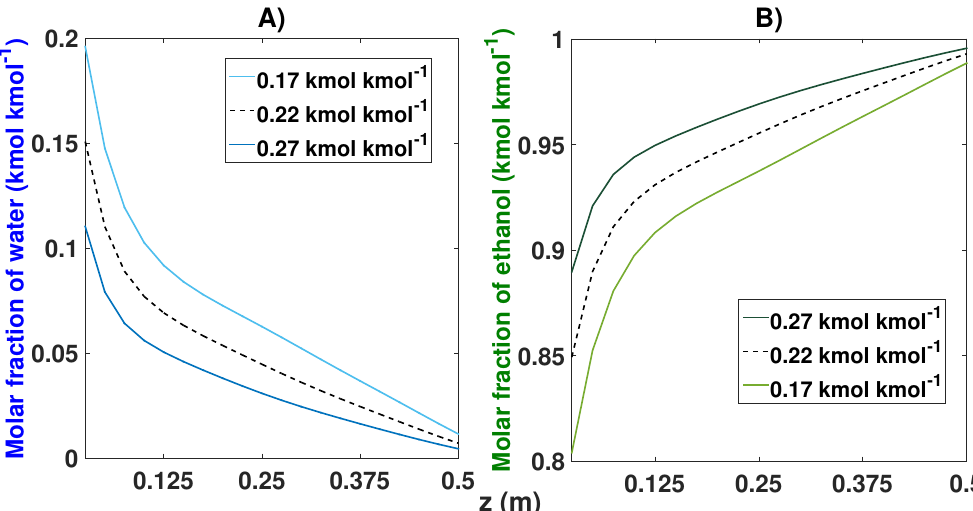
Figure 19. Molar fraction profile in the bed from the start-up and at CSS for three different compositions. ( A ) Effect of feed composition on the molar fraction of water; ( B ) Effect of feed composition on the molar fraction of ethanol.